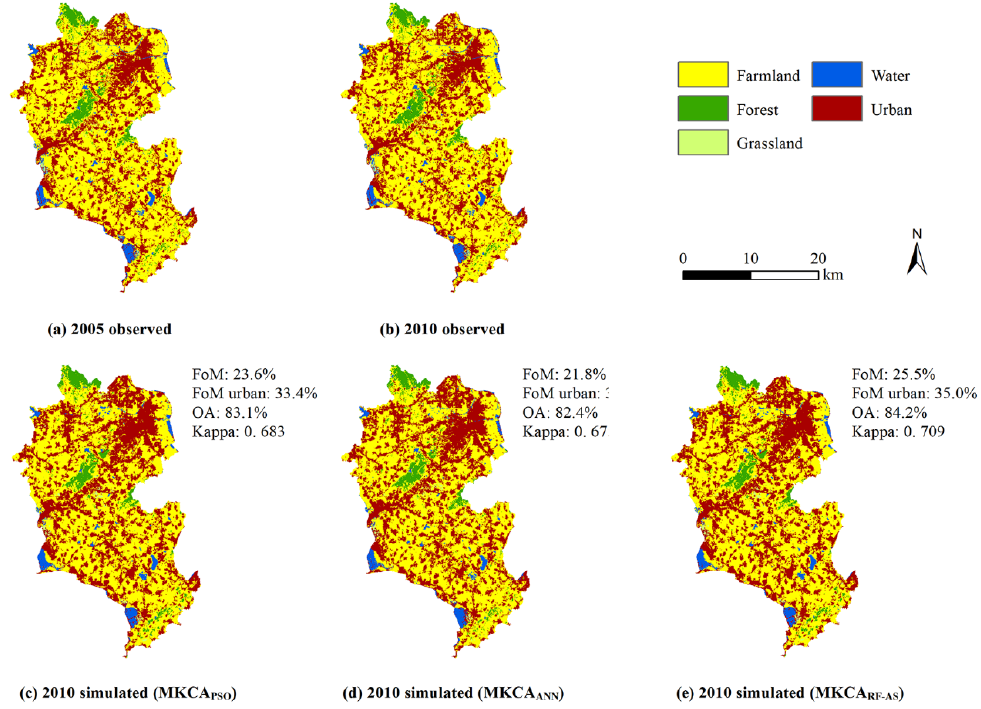
Figure 3. Comparison of spatial distribution of LULC simulated using different cellular automaton models.